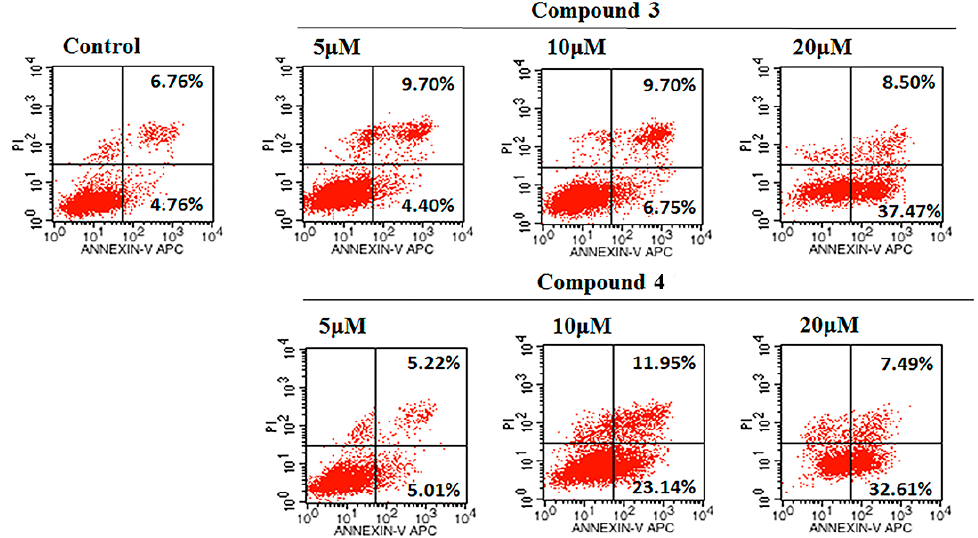
Figure 6. Apoptosis was assessed using Annexin V- fluorescein isothiocyanate (FITC) and propidium iodide (PI) staining after HeLa cells were treated with compounds 3 and 4 (5 μ M, 10 μ M, and 20 μ M) for 24 h, measured by flow cytometry.